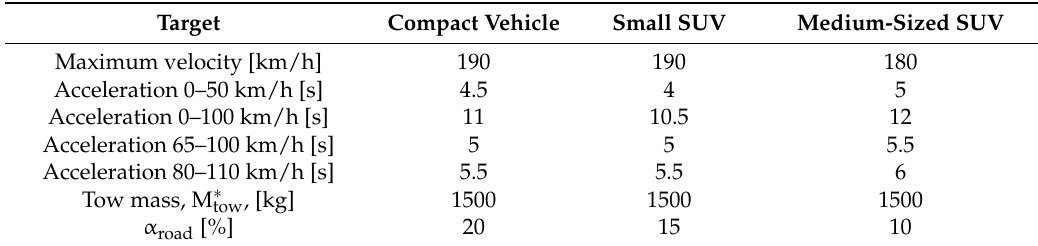
Table 6. Performance targets of the three vehicle